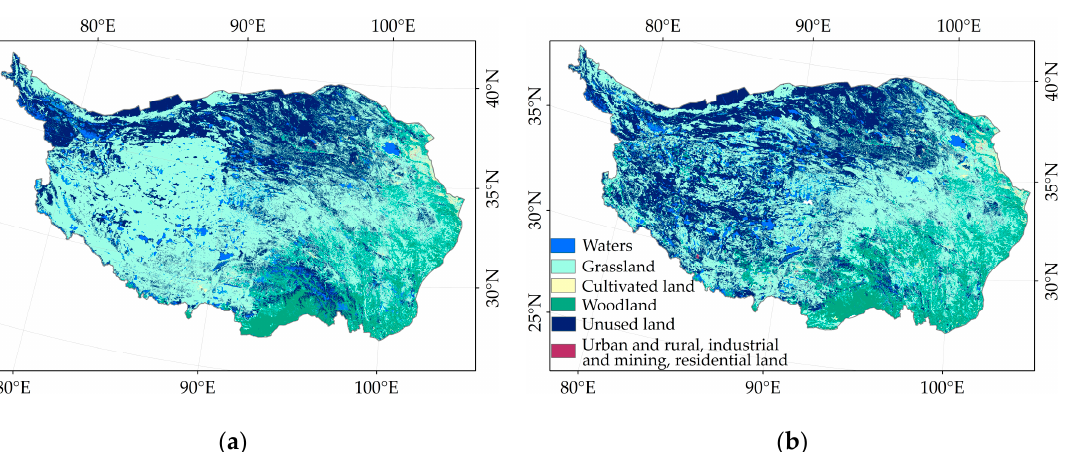
Figure 6. Land use and cover changes on the QTP: ( a ) 1980; ( b ) 2018.